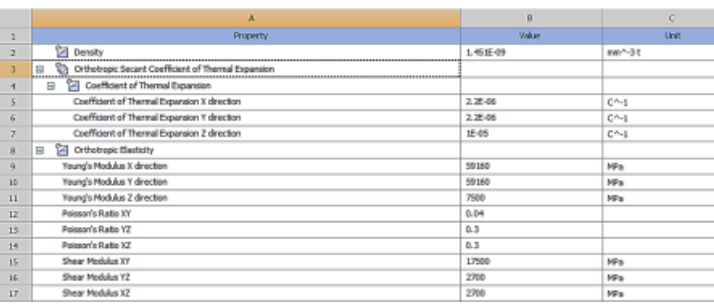
Figure 3: S-N curve